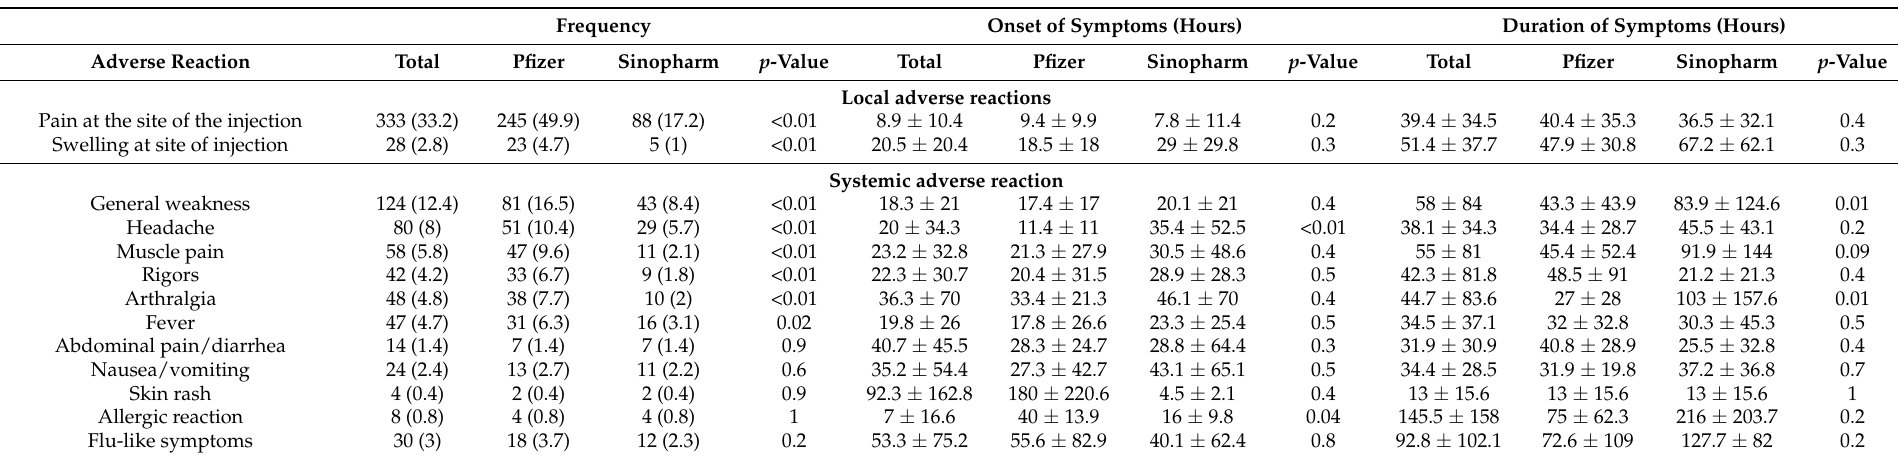
Table 3. The frequencies, onset, and duration of the specific adverse reactions after the first dose of the vaccine.